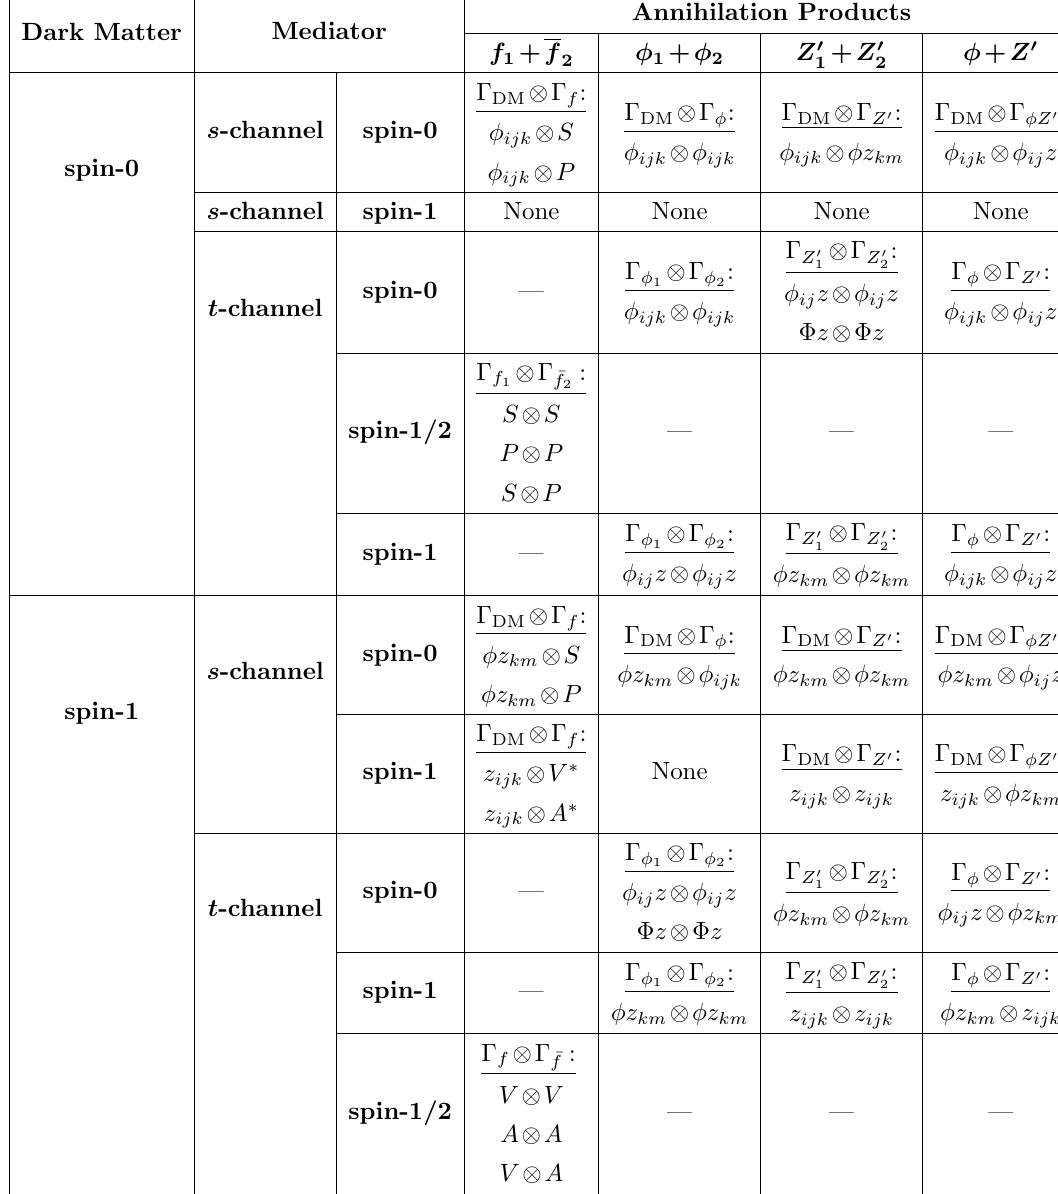
Table 2 . As in table 1, but for spin-0 or spin-1 dark matter candidates. We use the labels as indicated in eqs. (2.1){(2.5) to denote the types of interactions that lead to an s -wave annihilation amplitude. In those entries labeled \none", we found that none of the interactions described in this section lead to an s -wave amplitude for dark matter